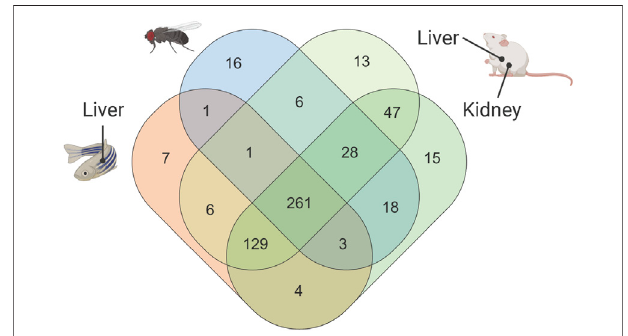
FIGURE 5 | Venn diagram showing number of metabolites that are common or unique across all sample types and model organisms within the 75EtOH/MTBE extraction protocol. A comparison of the remaining extraction protocols can be found in the supplement (see Supplementary Figure S5 ). A list of the metabolites that are unique and overlapping can be found in the supplementary data fi le (see supplementary Data File